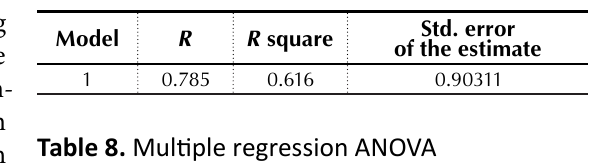
Table 7. Model summary of regression